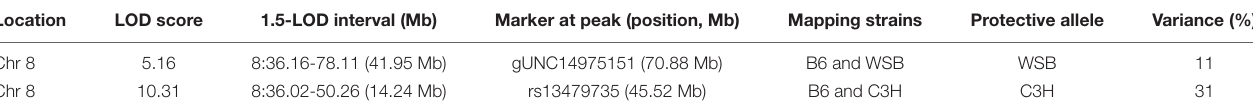
FIGURE 3 | Characterization of the location, size, and allelic effects on infarct volume at the Chromosome 8 locus. (A) The graph shows the QTL mapping across Chr 8 using 88 informative SNP markers. The LOD score at the peak is 5.16 (gUNC14975151), and the 1.5-LOD support interval is from 36.16 to 78.11 Mb, indicated by the red bar on the graph. The significance threshold for linkage was calculated using the 88 informative SNP markers on Chr 8. (B) Allelic effects on infarct volume of the F2 cohort at gUNC14975151. The B6 allele confers increased susceptibility to infarction and the WSB allele confers protection. Statistical analysis was performed with one-way ANOVA followed by Tukey’s multiple comparison test ( ∗∗ p < 0.01; ∗∗∗ p < 0.001). NS, not significant. TABLE 1 | Characteristics of two independent QTL mappings for surgically induced ischemic infarct volume. Location LOD